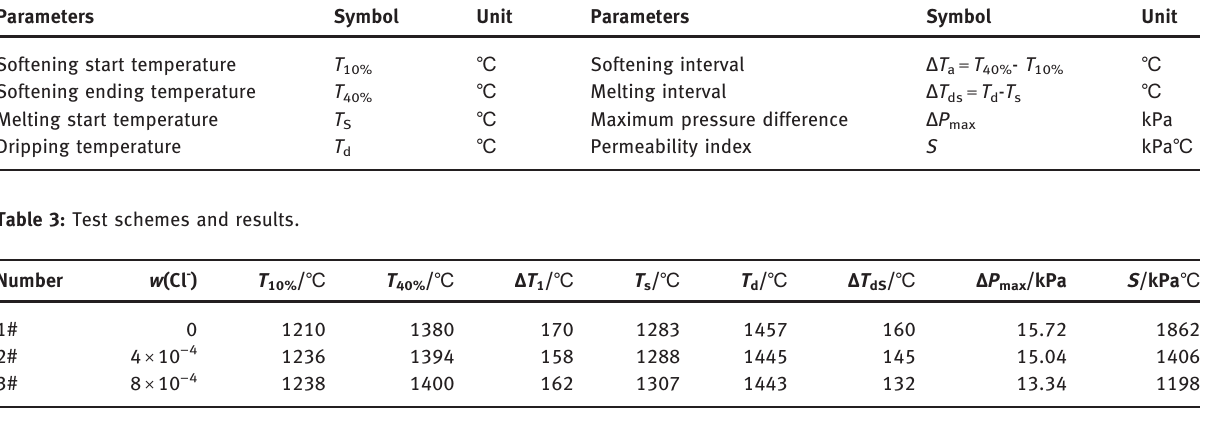
Table 2: Test parameters of softing and melting behavior of burden. Parameters